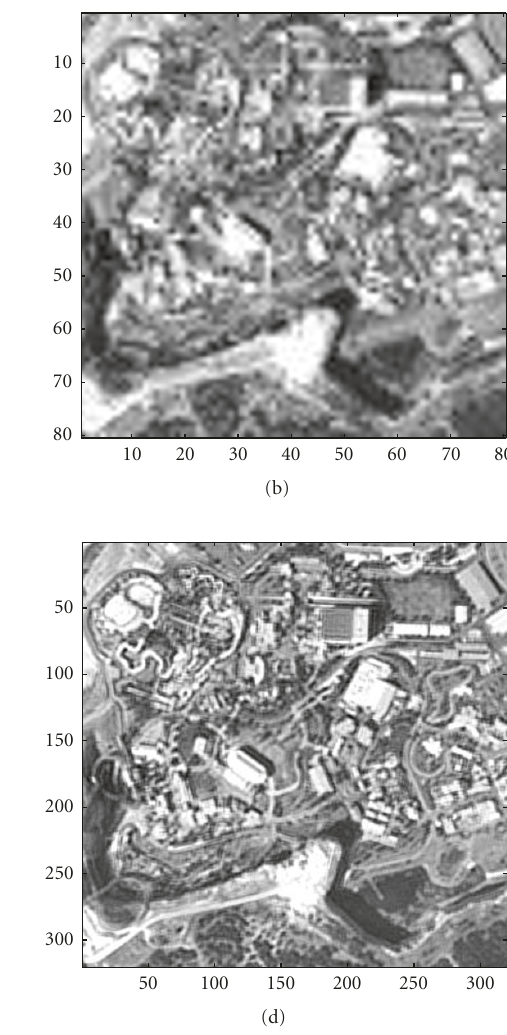
Figure 2: Simulated images: (a) true high-resolution image; (b) simulated frame-one low-resolution image; (c) observed frame-one low- resolution image with σ 2 n = 4 and σ 2 b = 400; (d) restored frame-one using the MAP SR-NUC algorithm for P = 30